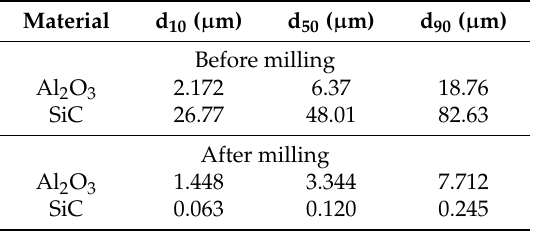
Figure 1. Particle size distribution before and after milling for ( a ) alumina; ( b ) SiC powder. Table 1. Size variation of the different milled composite powders produced.